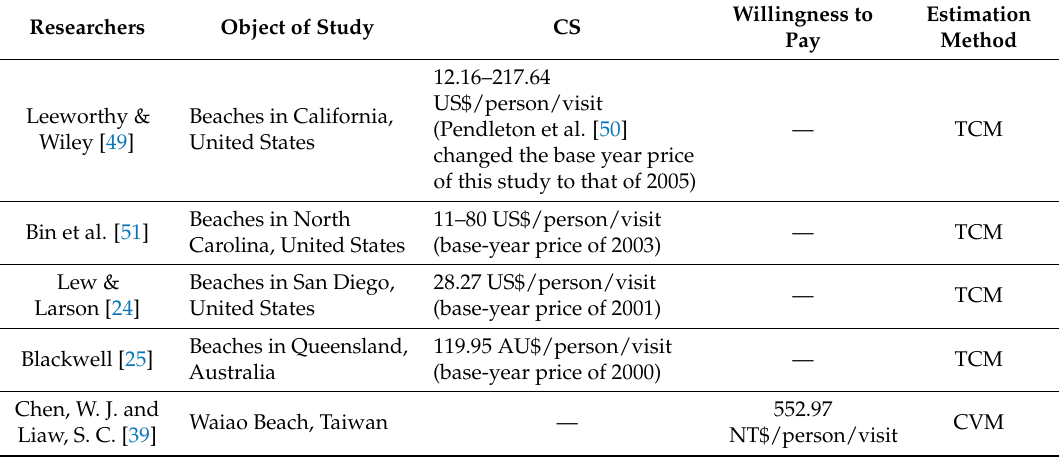
Table 12. Empirical studies on beaches in Taiwan and other